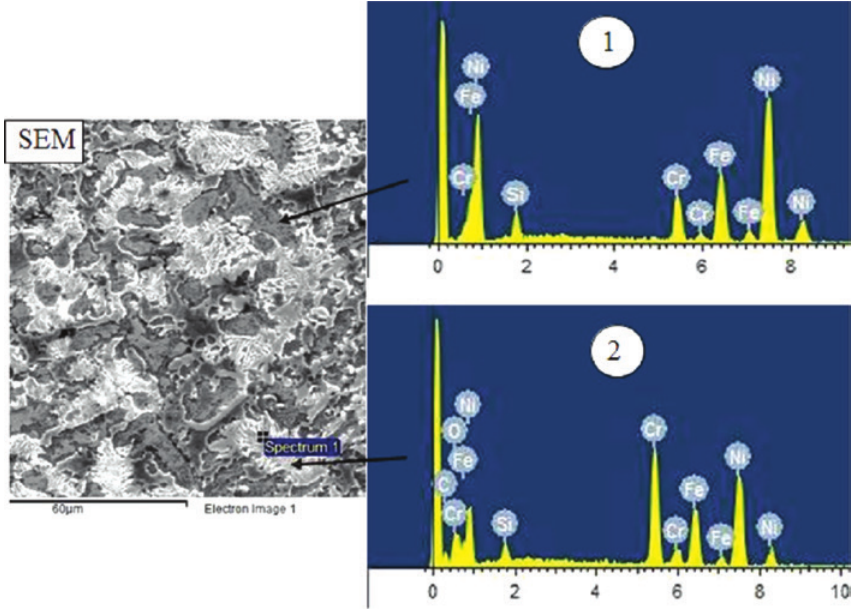
Figure 9: Scanning electron micrograph of the deposit and spot EDS (optimized condition).